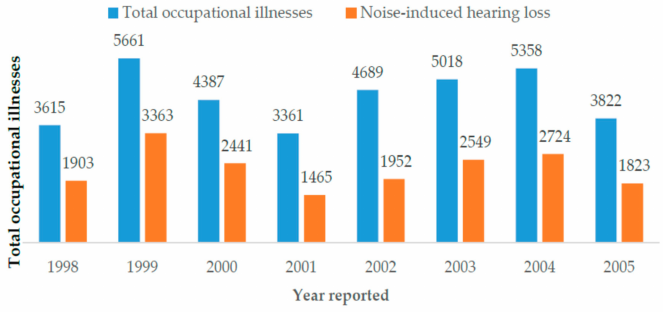
Figure 2. Occupational illnesses reported in South Africa.